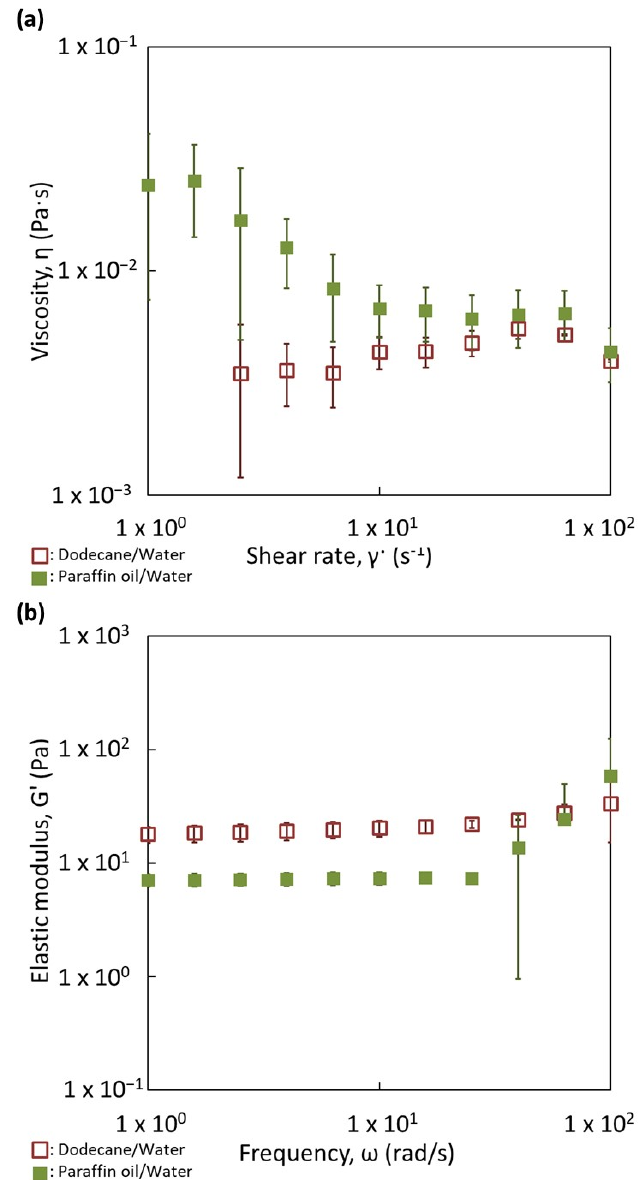
Figure 8. Comparison of the rheological behavior of Paraffin/Water and Dodecane/Water direct emulsions prepared with ( a ) 1 wt.% and ( b ) 4 wt.% of partially hydrophobic silica particles. ( a ) Flow curves. ( b ) Mechanical spectra.